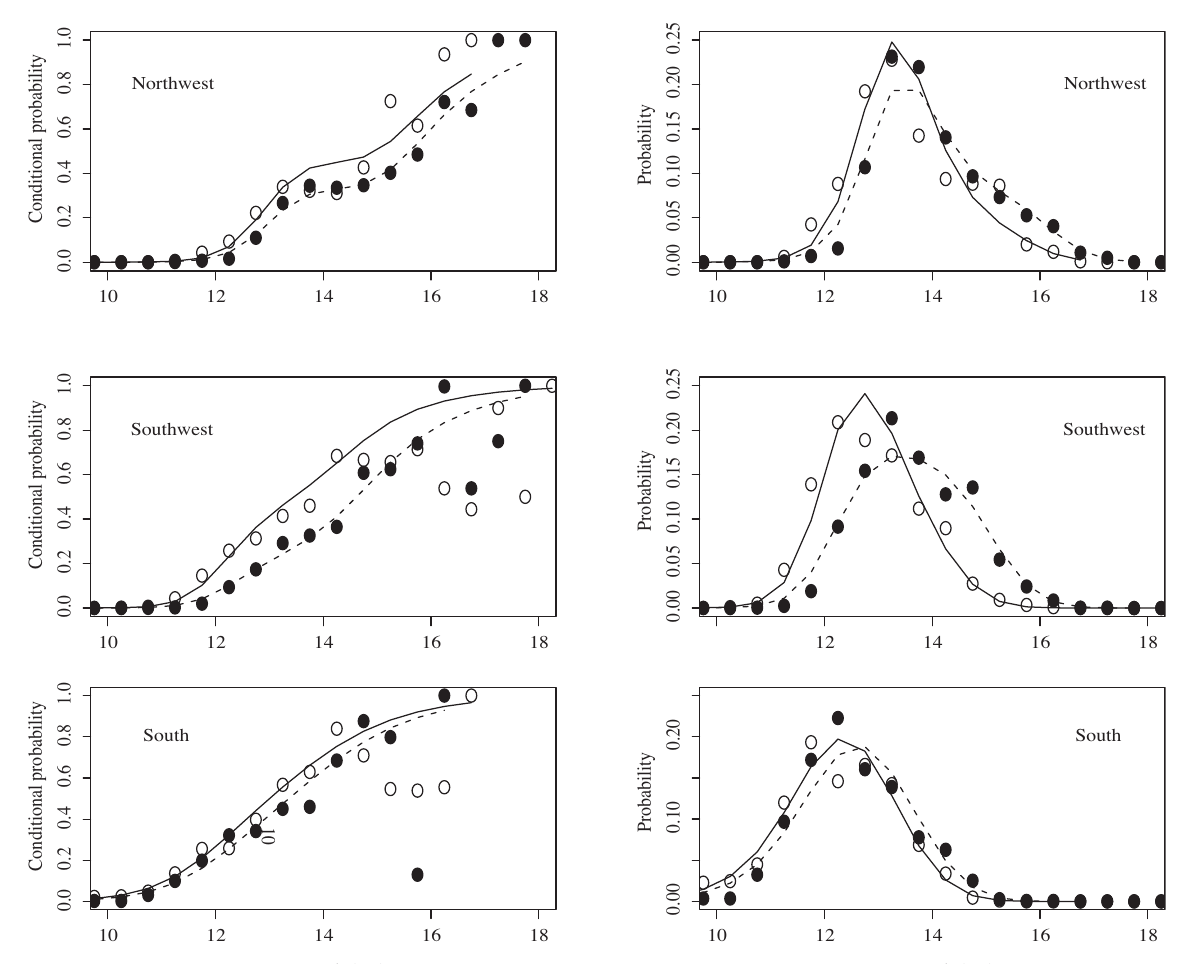
F IG . 6.– Snipefish length distribution off Portugal: conditional (left) and unconditional (right) probabilities of being at length in each geo- graphical area and period (open circles: observations in early period; closed circles: observations in late period; solid lines: model fit in early period; broken lines: model fit in late